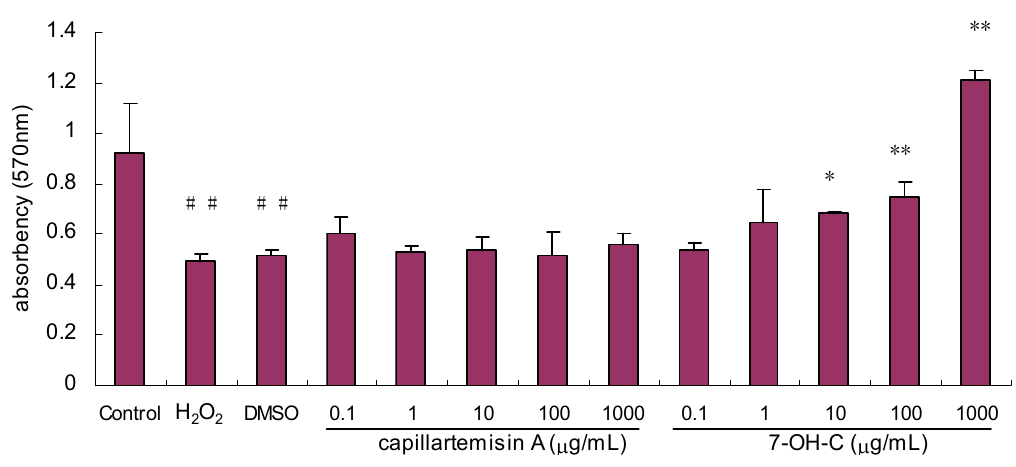
Figure 7. Effect of compounds on proliferation/viability of HL77-02 hepatocytes injured O . ## p < 0.01 vs. control; * p < 0.05, ** p < 0.01 vs. DMSO by H 2 2